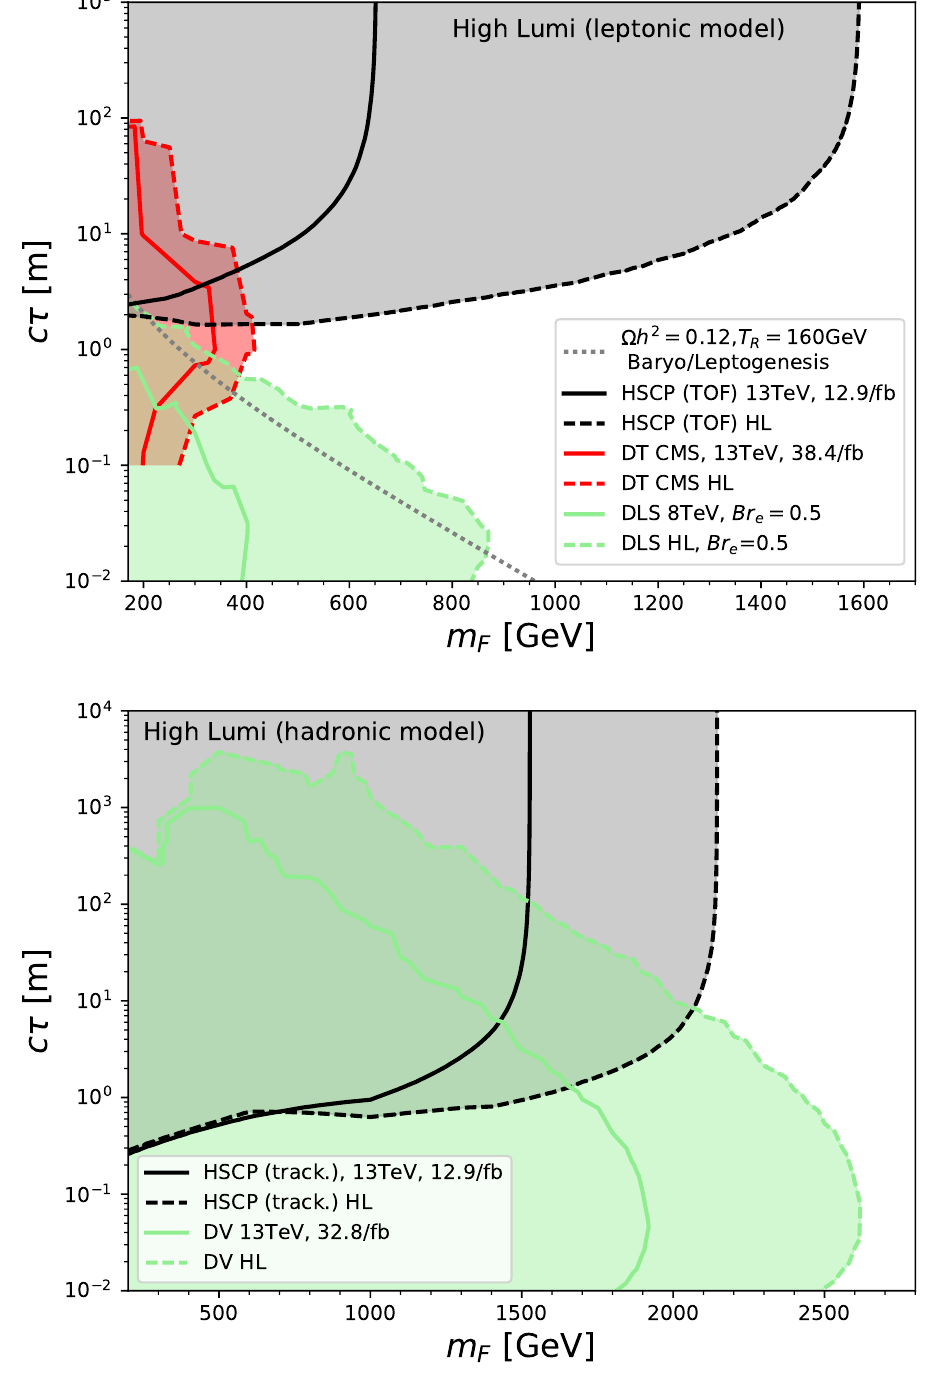
Figure 8 . Summary of the high luminosity LHC projections for the lepton-like (upper panel) and the quark-like (lower panel) FIMP scenarios. The lines correspond to contours of (cid:10) s h 2 = 0 : 12 for the values of m s and T R given in the legend. See text for details.